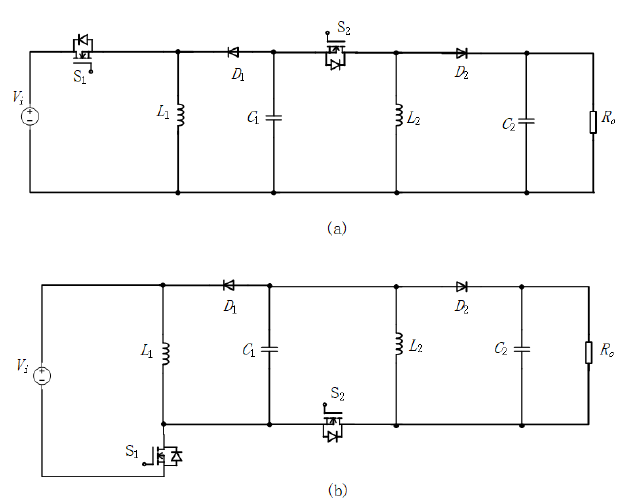
Figure 22. Basic quadratic DC-DC converters. ( a ) Basic structure. ( b ) Improved structure.